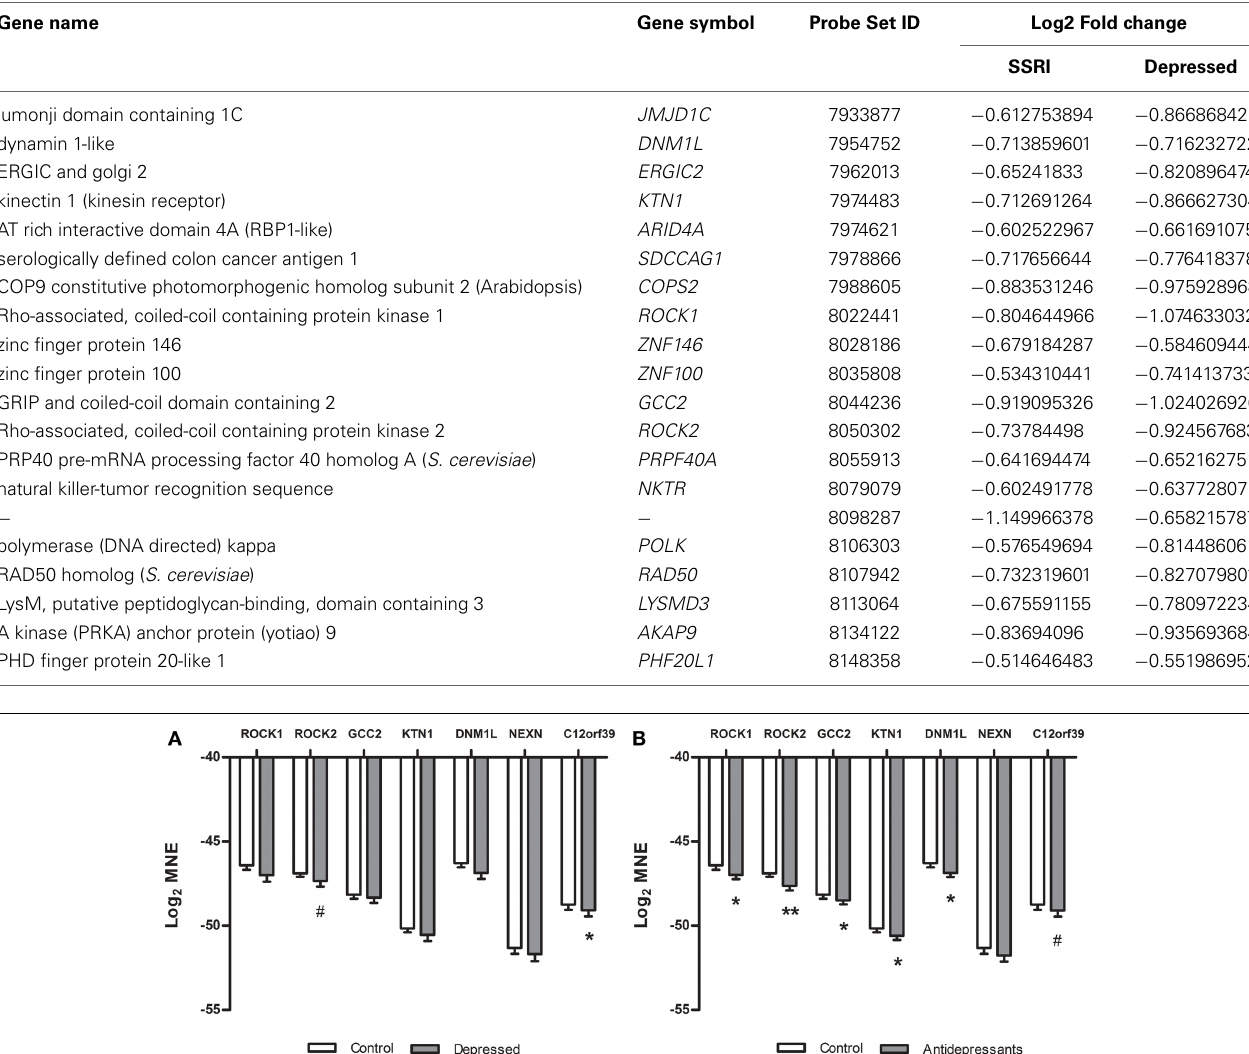
Table 11 | Genes commonly altered in depressed and SSRI groups compared with controls. ( − = reduction in expression levels).